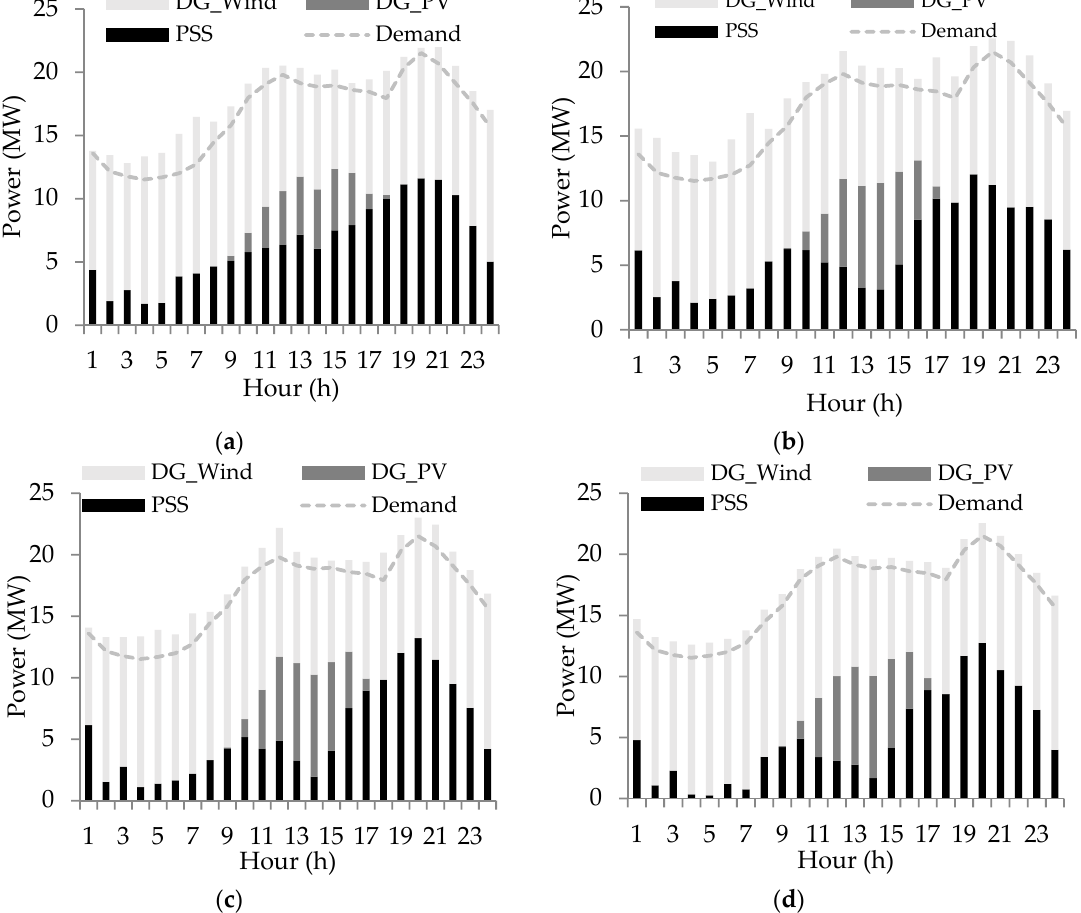
Figure 4. Energy mixes for different case studies. ( a ) Case C energy mix (30% meshed network); ( b ) Case D energy mix (60% meshed network); ( c ) Case E energy mix (80% meshed network); and ( d ) Case F energy mix (100% meshed